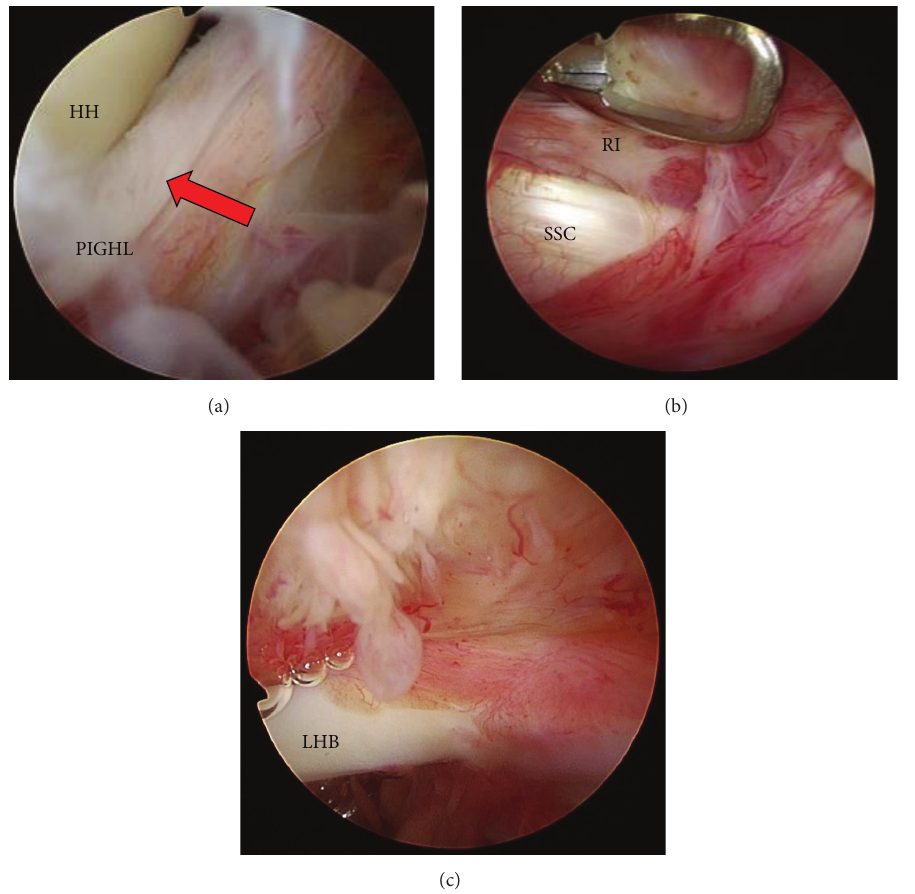
Figure 2: Arthroscopic findings in Case 2. LHB: long head of the biceps tendon. (a) Posterior capsule was partially ruptured by manipulation under anesthesia. (b) Before release of the rotator interval. (c) Proliferation of bursa and adhesion of the superior capsule.